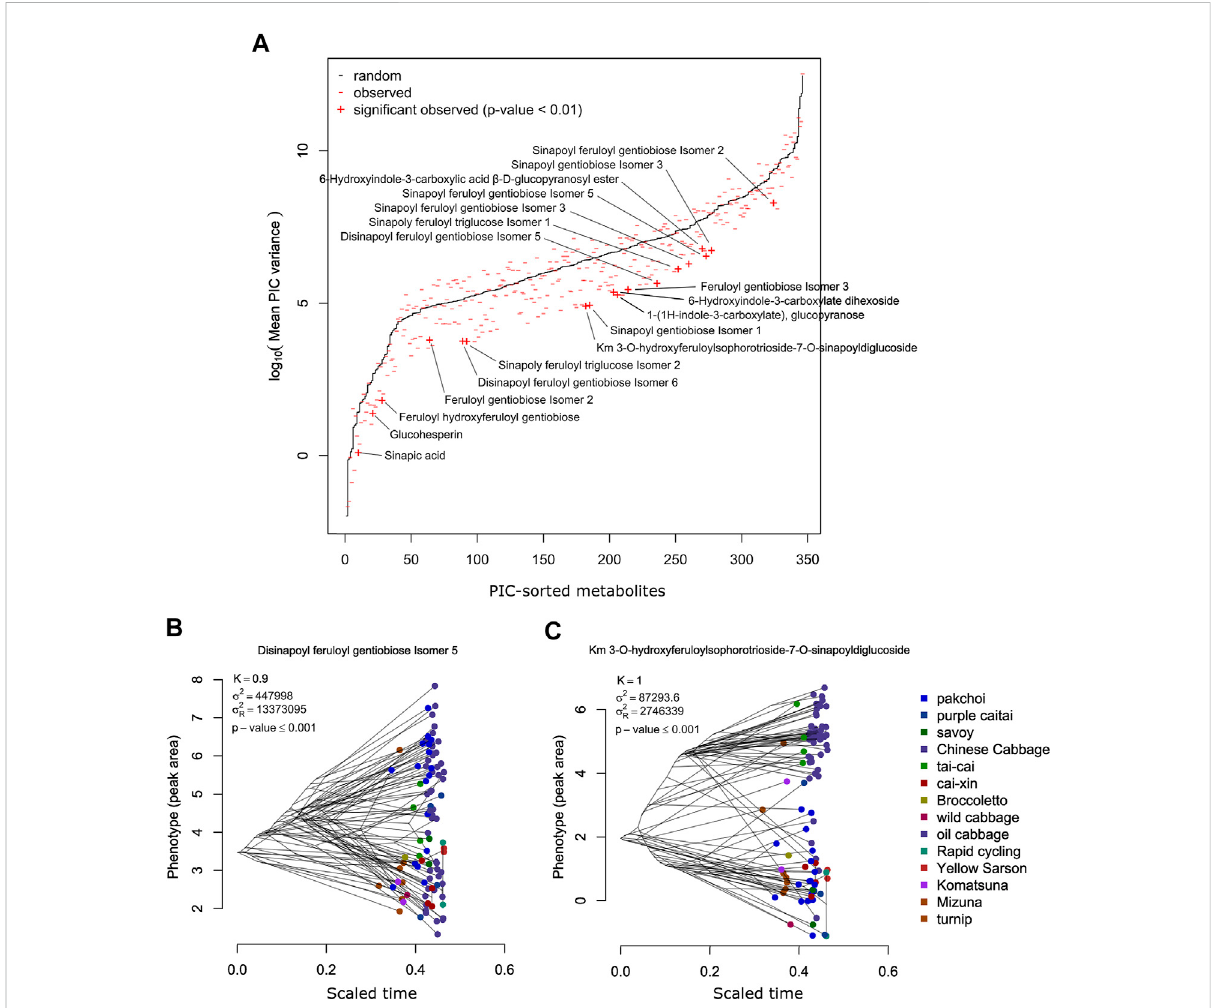
FIGURE 4 (A) Comparison of the PIC values expected from the random Brownian motion model (black) and PIC observed for the measured metabolites. Metabolitesexhibitingsigni fi cantlylowerPIC( p -value ≤ 0.01)arelabeled. (B) Phenogramofthedisinapoylferuloylgentiobioseisomer5 — anexample of a metabolite exhibiting high and signi fi cant phylogenetic signal. (C) Phenogram of the km 3-O-hydroxyferuloylsophorotrioside-7-O- sinapoyldiglucoside — another example of a metabolite exhibiting high and signi fi cant phylogenetic